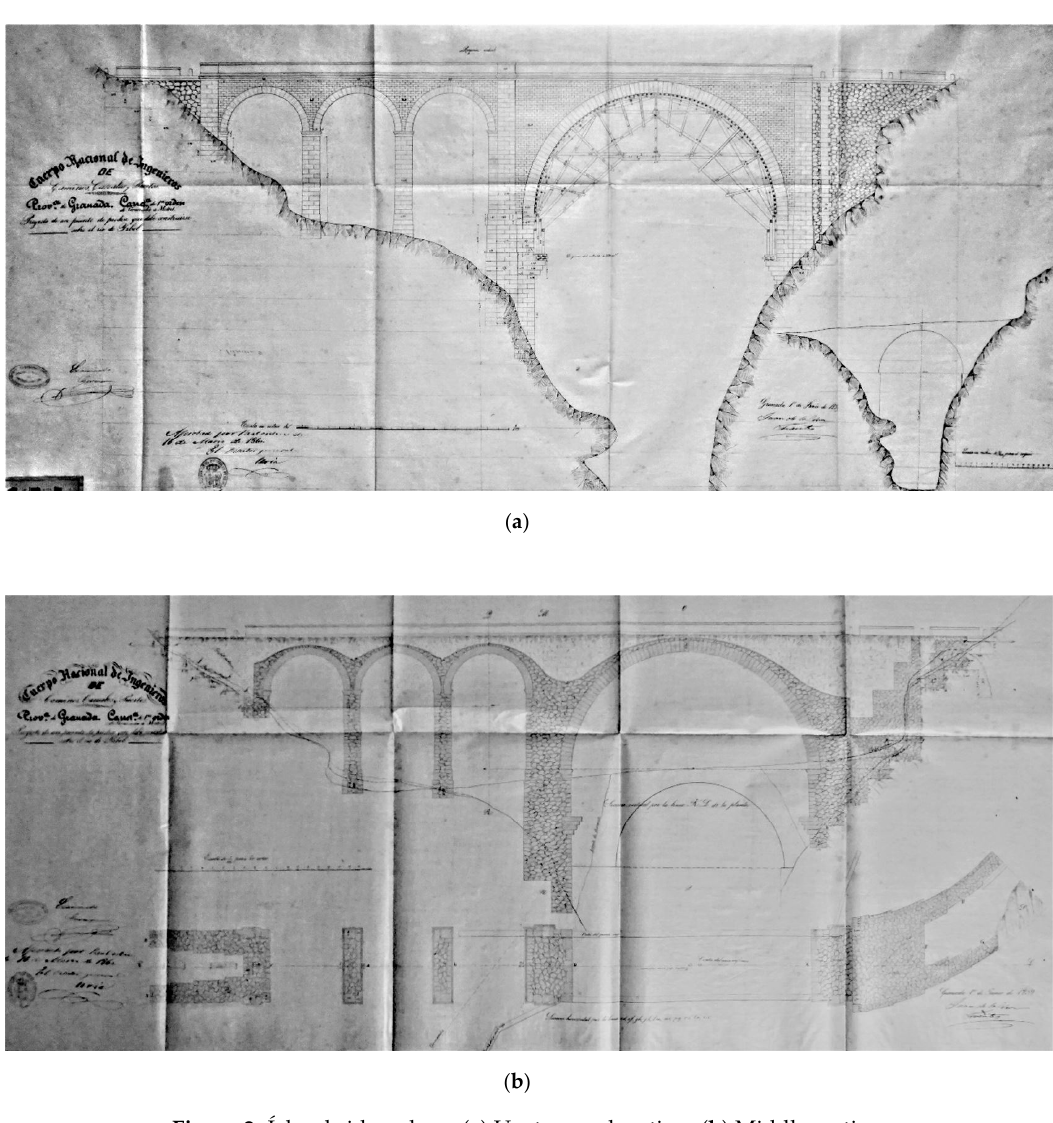
Figure 2. Ízbor bridge plans. ( a ) Upstream elevation. ( b ) Middle section. Figure 2. Í zbor bridge plans. ( a ) Upstream elevation. ( b ) Middle